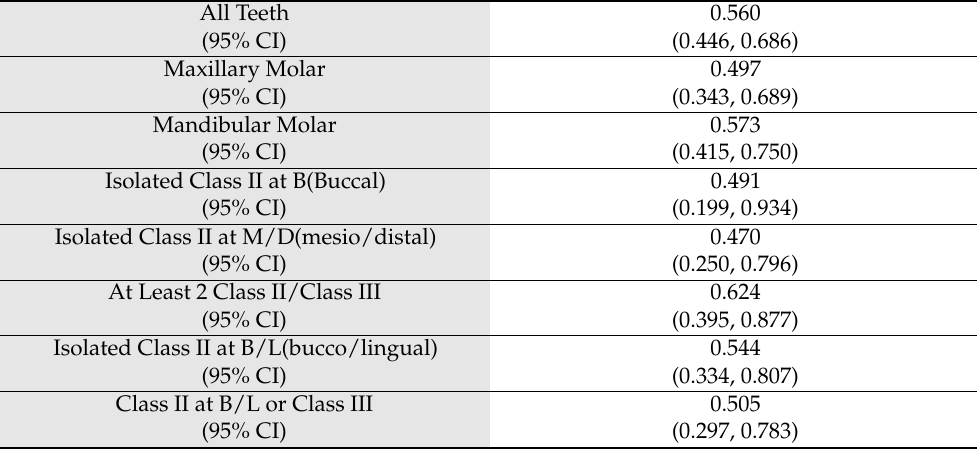
Table 3. Intraclass correlation coefficient (ICC) for assessment of reliability among the 15 examiners using the conventional modality in measuring vertical depth of